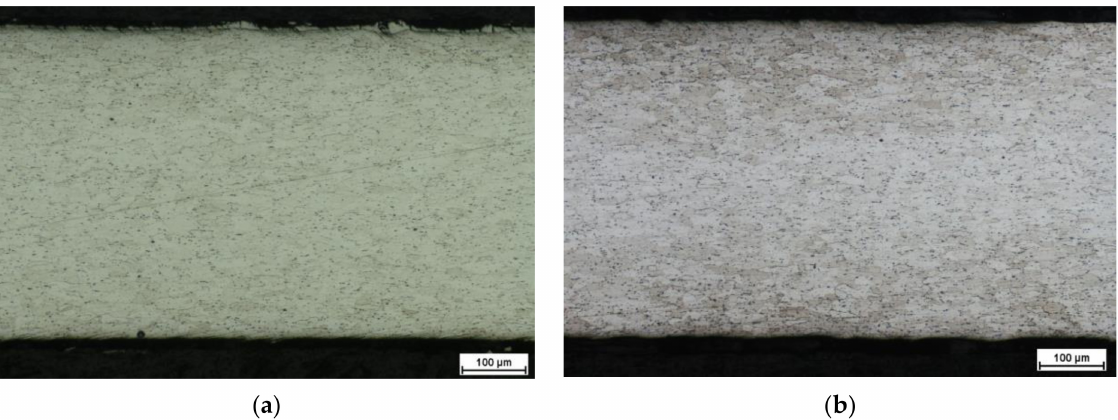
Figure 12. Images of the microstructure of the tested material: ( a ) raw material, ( b ) after nitriding.